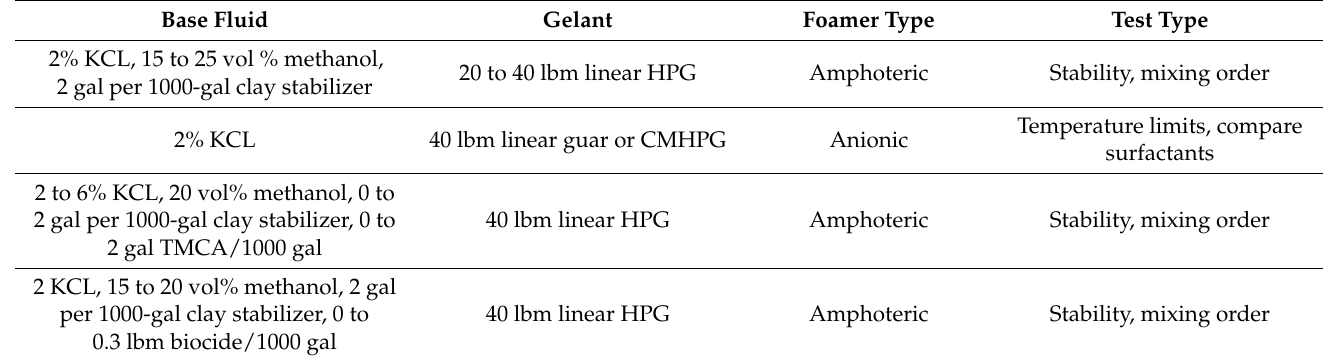
Table 1. Properties of different foam used to study the effect of temperature on rheology (Adapted with permission from Hutchins & Miller, [29]). Copyright 2005, Society of Petroleum Engineers.